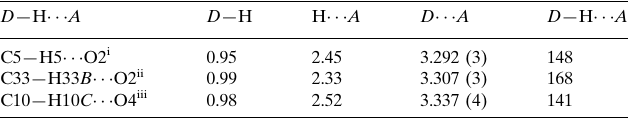
Hydrogen-bond geometry (A˚ , (cid:1)